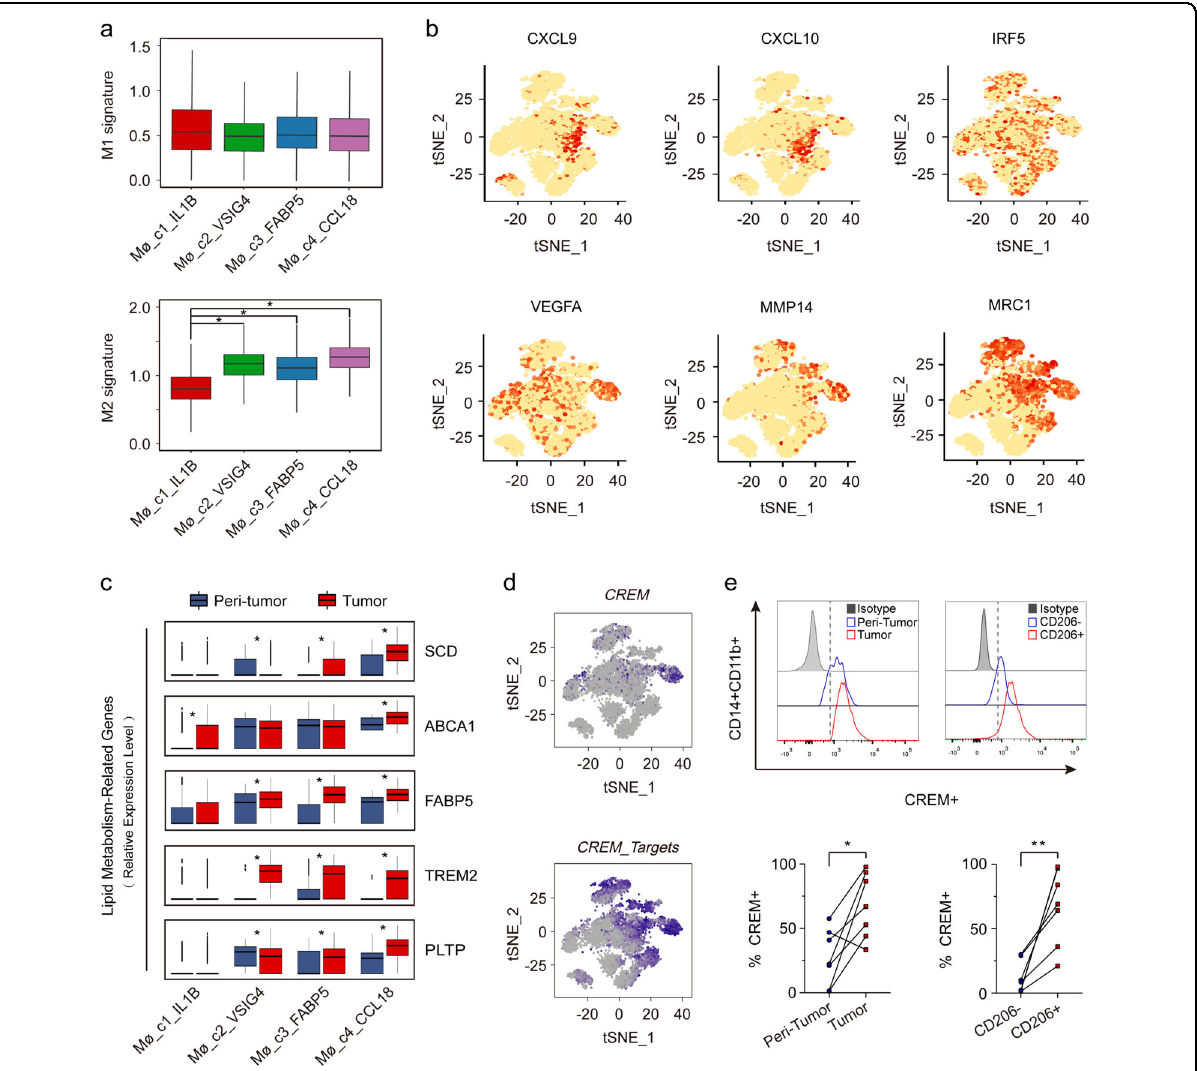
Fig. 3 Transcriptome heterogeneity of four subsets of macrophages. a Module scores of M1 and M2 expression signatures de fi ned by Azizi et al. 14 (Genes list in Supplementary Table S5) for each macrophage subset at single-cell level. * P < 0.01. b t-SNE plots of M1 (top) and M2 (bottom) expression signatures. c The expression of lipid metabolism-related genes plotted via boxplots. * P < 0.01. d t-SNE plots for the expression of CREM and regulation of its target genes. e Representative fl ow cytometry plots (top) and statistics (bottom) of CREM expression in CD14 + CD11b + macrophages from HCC tumor or peri-tumor, and CD14 + CD11b + CD206 − or CD14 + CD11b + CD206 + macrophages. Data analyzed by wilcoxon matched-pairs signed rank test. * P < 0.05, ** P <